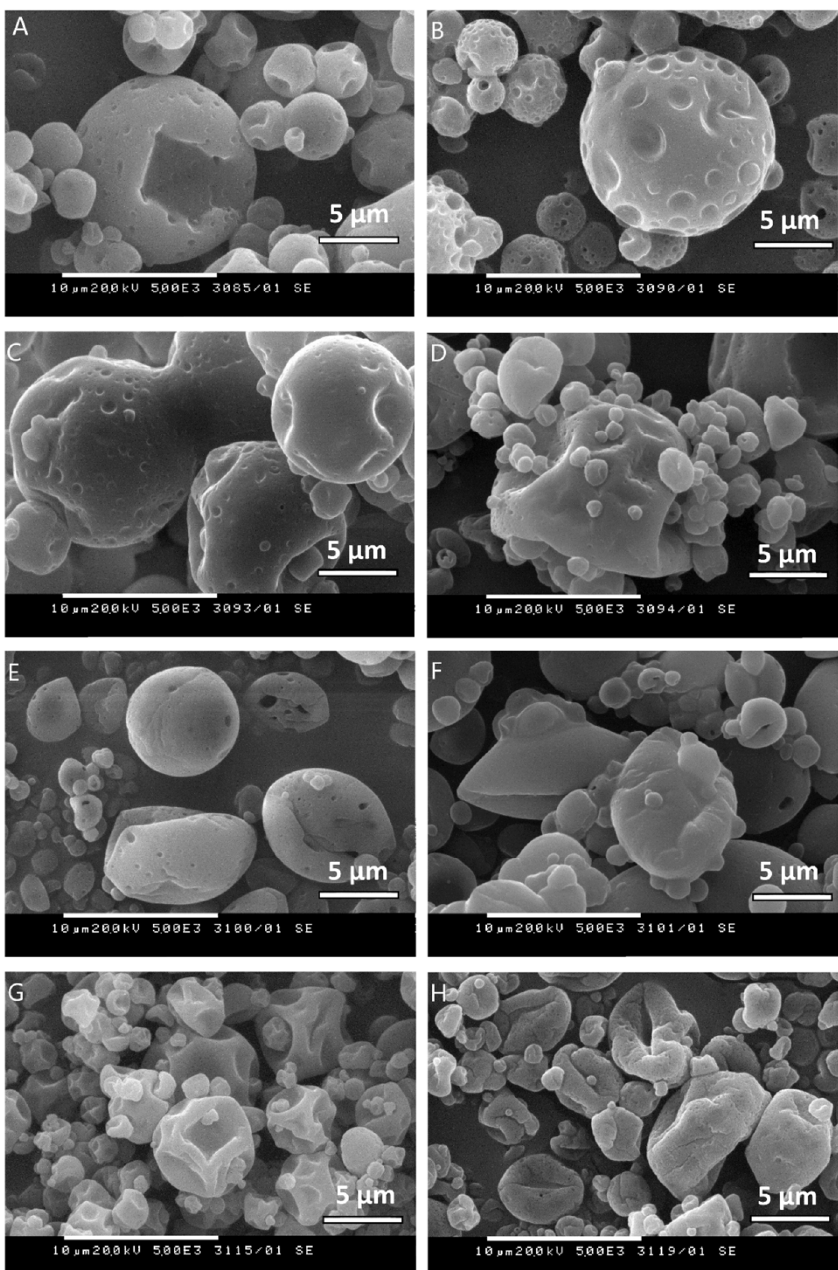
Figure 1. SEM micrographs of the spray dried samples: LO-5-AG-20 ( A ), LO-2.5-AG-10 ( B ), LO-5-AG-MD-15/5 ( C ), LO-5-AG-MD-10/10 ( D ), LO-5-AG-MD-5/15 ( E ), LO-5-MD-20 ( F ), PO-5-AG-20 ( G ), PO-2.5-AG-10 ( H ), magnification 5000×.